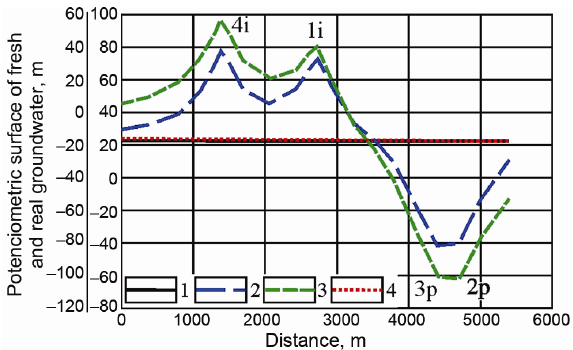
Fig. 8. Variation of piezometric surface of Viešvilė aquifer: 1 – initial; 2 – after 1 year; 3 – after 50 years of exploitations of wells at project rate; 4 – 100 year after plant stoppage (in the direction of A-A